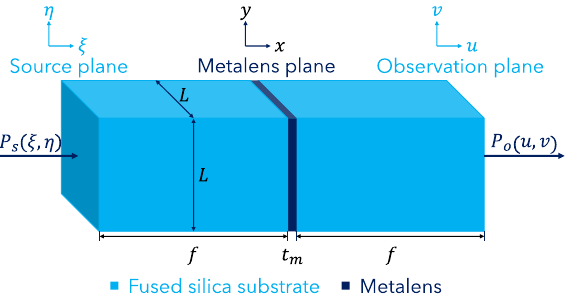
Figure 1. Schematic of the UFT-ACS. The figure shows a schematic of the UFT-ACS, which consists of five main parts: the input pressure field P s (ξ , η) at the source plane, a substrate layer (light blue), the ultrasonic metalens (dark blue), another substrate layer (light blue), and the output pressure field P o ( u , v ) at the observation plane.